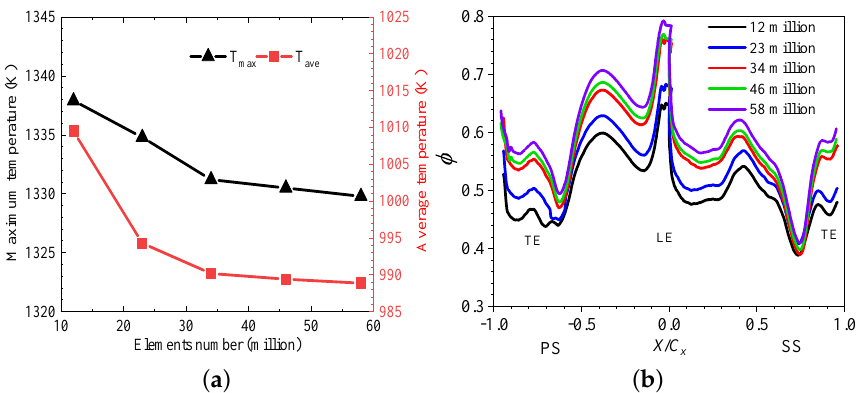
Figure 3. Grid independence verification for CHT analysis: ( a ) the maximum and average tempera- ture for the blade; ( b ) the overall cooling efficiency at the 50% blade span, C x is the axial chord length of the 50% blade span.